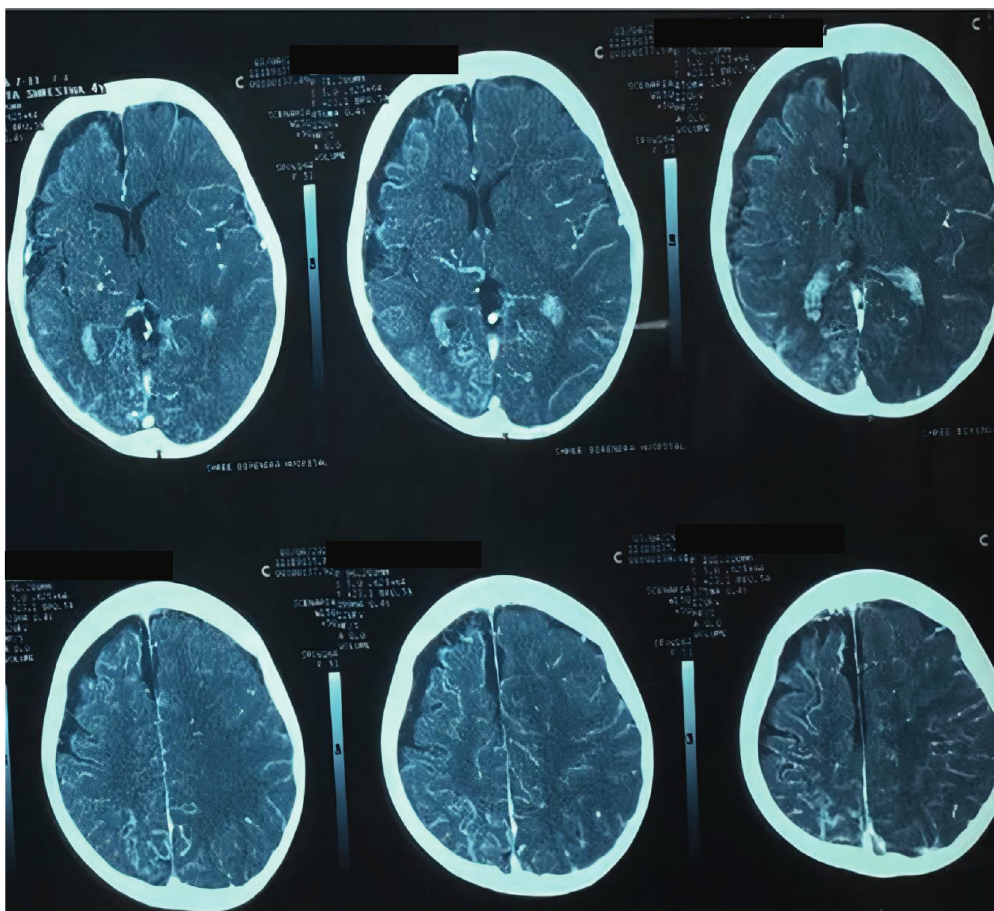
Figure 2: CT head (with angiography) showing volume loss of right brain parenchyma and linear